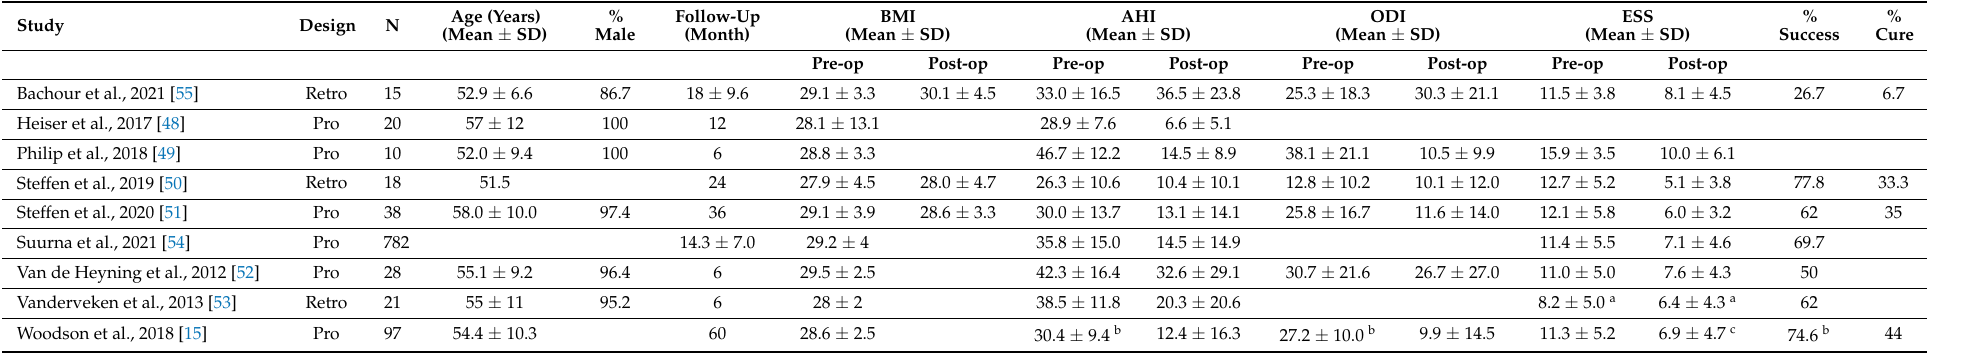
Table 2. Characteristics of studies on upper airway